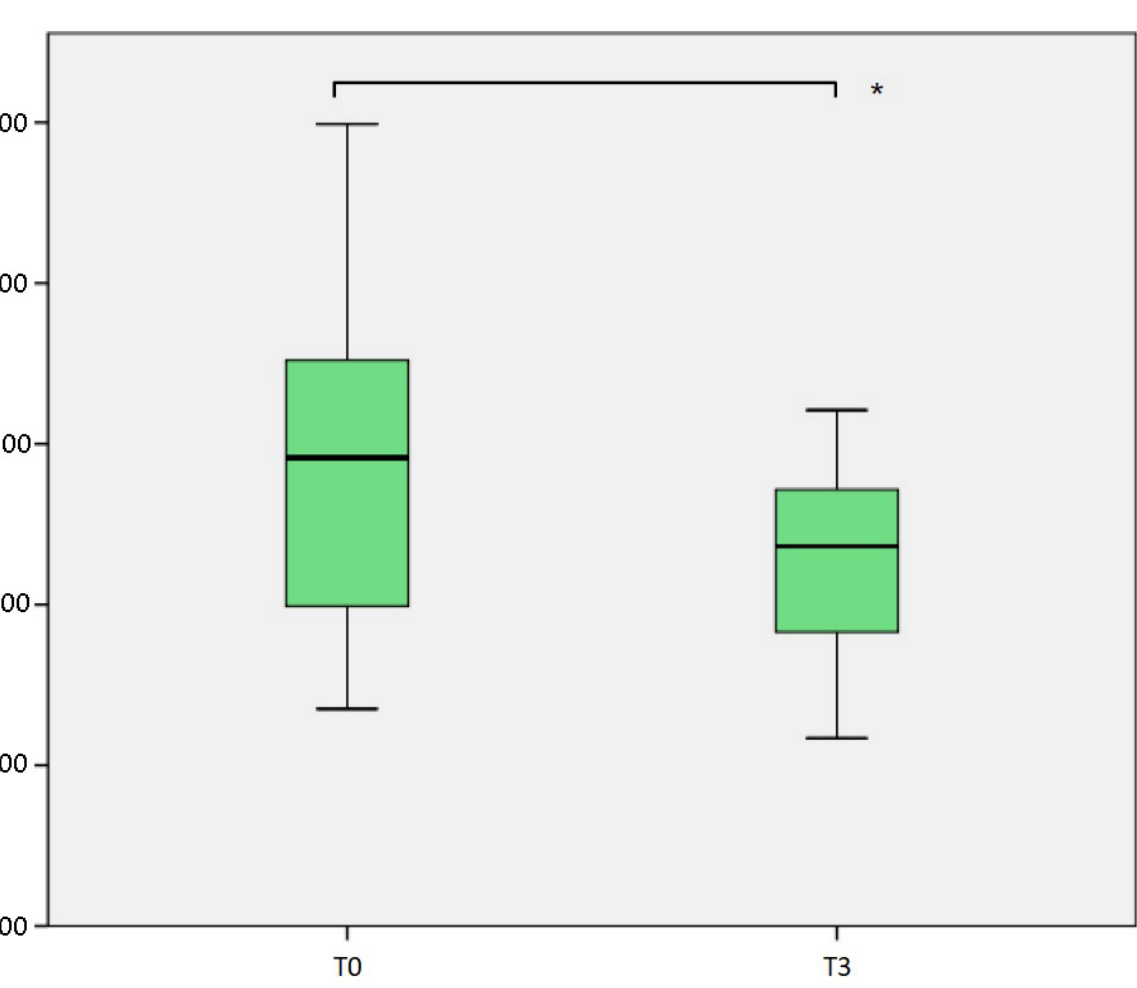
Figure 2. Comparison of Advanced Oxidation Protein Products (AOPP) measured at baseline (T0) and after 6 months (T3). * p = 0.004.